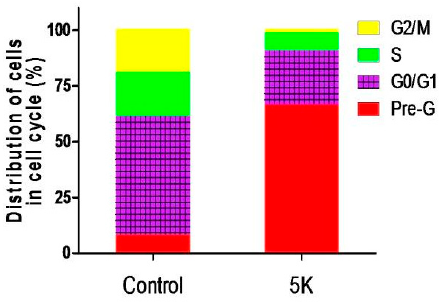
Figure 5. Bar chart shows percentage of MDA-MB-468 cells at each phase of cell cycle in control cells and cells treated with compound 5k .